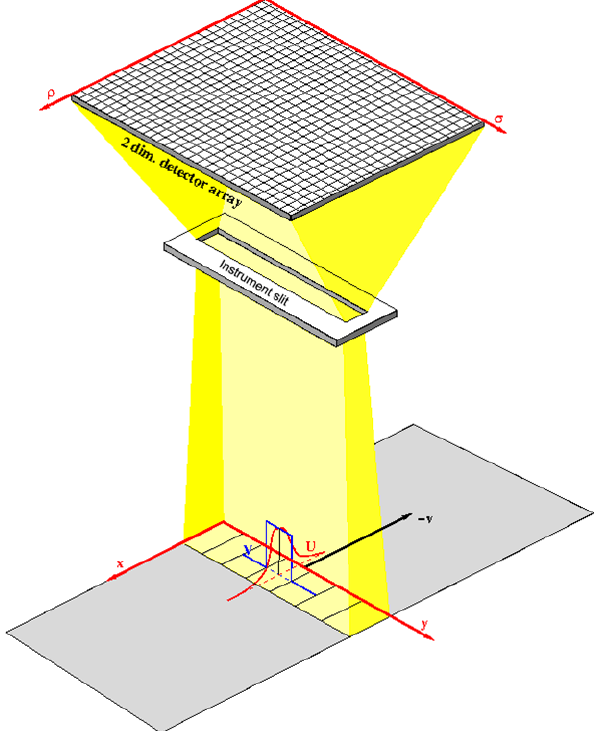
Figure B1. Slit and detector geometry with respect to the ground track of TROPOMI. Detector coordinate ρ describes the spectral sampling dimension, and σ is the spatial sampling coordinate. The scene coordinates are x in the flight direction and y in the across- flight direction, and U and V represent the corresponding instru- ment response in both spatial dimensions. The slit is aligned with the TROPOMI swath, such that scene heterogeneity in the flight di- rection interferes with the spectral response of the